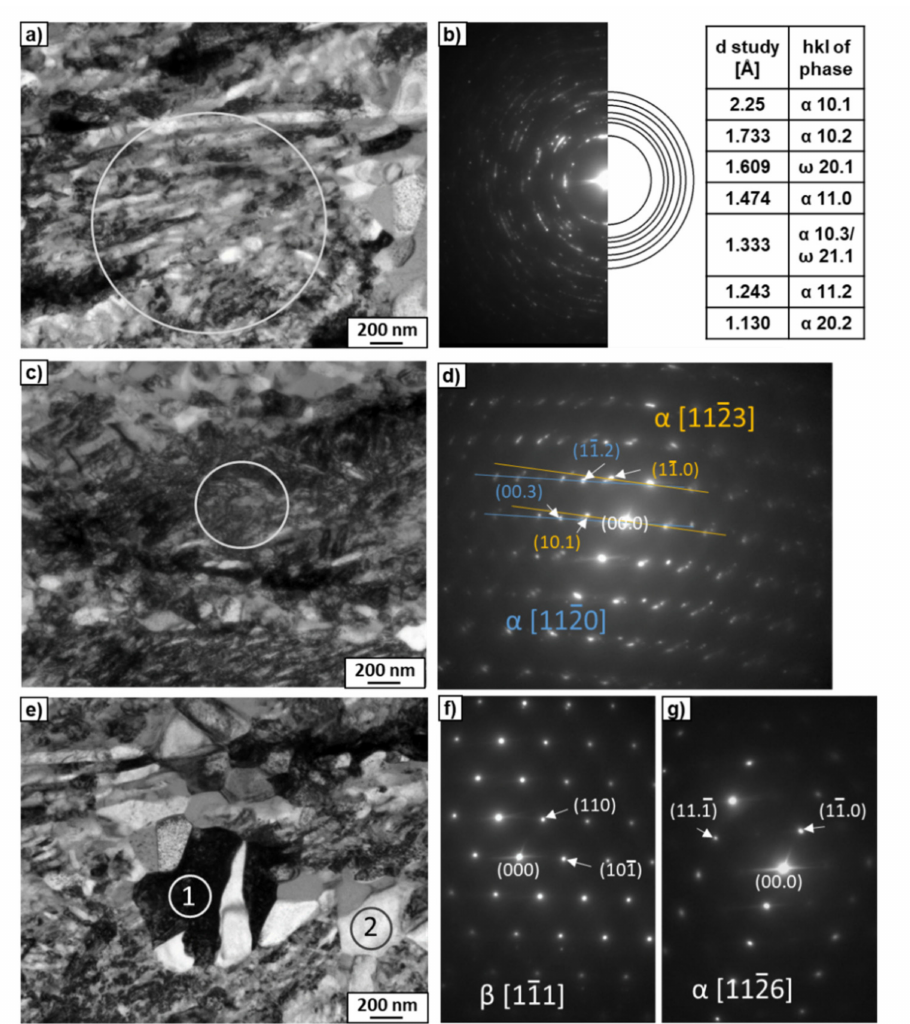
Figure 13. TEM micrographs of the Ti–18wt.% Mo after HPT and heating at 620 ◦ C. Bright-field images ( a , c , e ) with SAED patterns ( b , d , f , g ). SAED patterns ( b , d ) were taken from the areas marked by rings in ( a , c ), respectively. The SAED patterns ( f , g ) were taken from grains marked as 1 and 2 in ( e ),